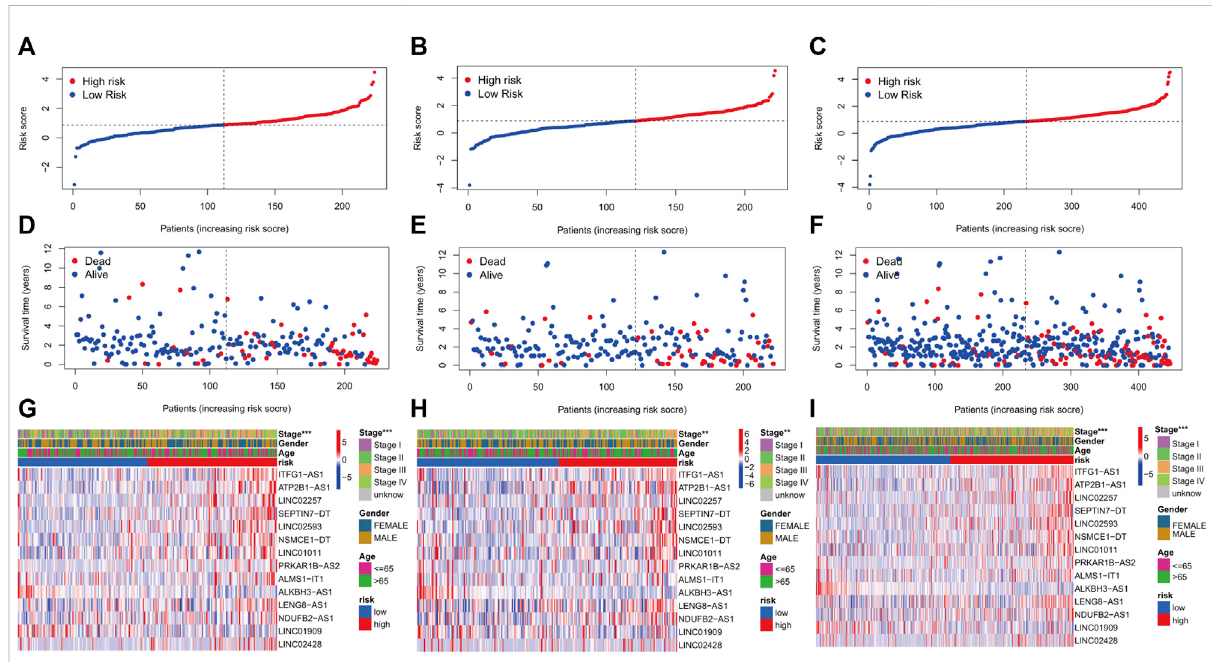
FIGURE 4 m7G-related prognostic signature in COAD. (A – C) Distribution of samples ’ risk scores in risk subgroups in the development set (A) , validation set (B), and complete set (C) . (D – F) Survival status for samples in the development set (D) , validation set (E), and complete set (F) . (G – I) Distribution heatmap of prognostic m7G-related lncRNAs and clinical baseline features in risk subgroups in the development set ( G , stage: p < 0.001), validation set ( H , stage: p < 0.01), and complete set ( I , stage: p < 0.001). ( p < 0.001, “ *** ” ; p < 0.01, “ ** ” ; p < 0.05, “ * ” ).